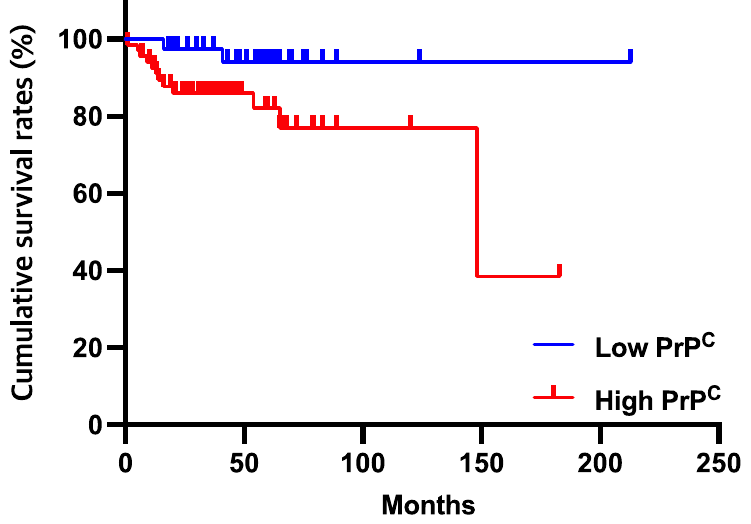
Figure 2. The cumulative survival rates in HCC patients with high PrP C were significantly lower than those of patients with low PrP C ( p = 0.043). The patients with high PrP C showed cumulative survival rates of 93%, 87%, and 85% at 1, 3, and 5 years, respectively. However, the proportion of patients with low PrP C were 95%, 95%, and 95%, respectively.